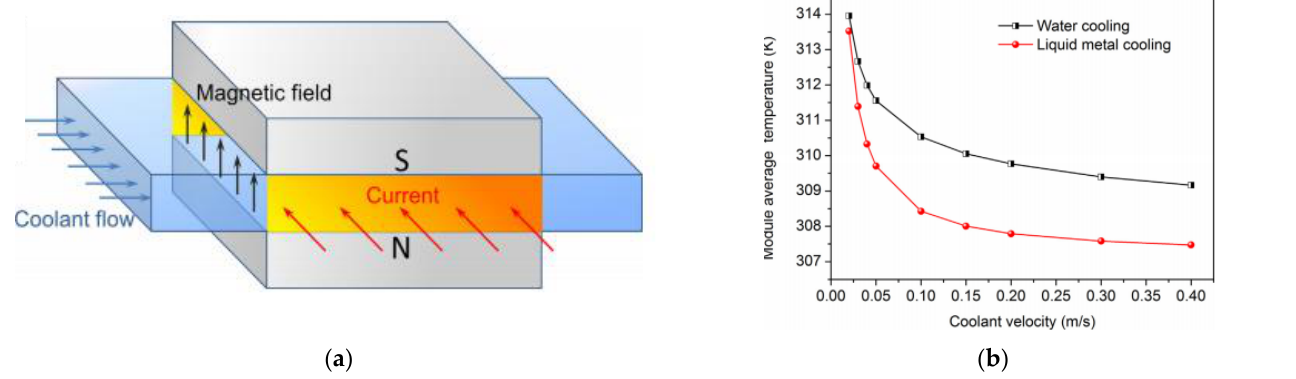
Figure 21. ( a ) Working principle of an electromagnetic pump (EMP). ( b ) A comparison of module average temperature between liquid metal cooling and water cooling. Reprinted with permission from [120] . Copyright 2016 Elsevier. Table 4. Recent developments in liquid-based battery thermal management methods.